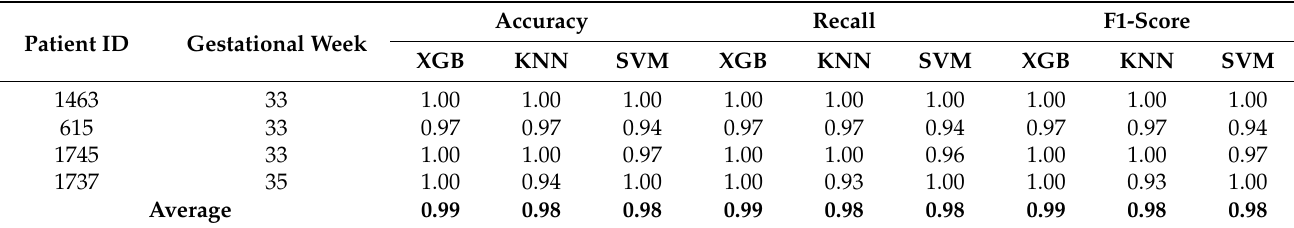
Table 1. Scores of the classification algorithms for different signals.